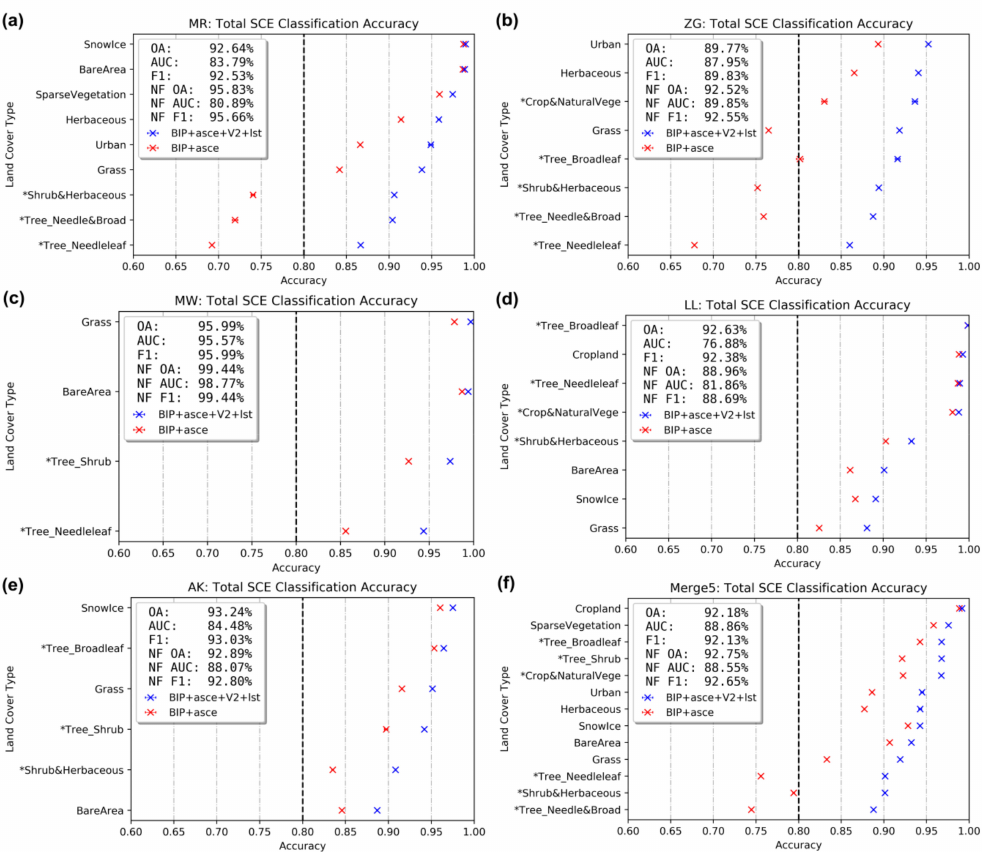
Figure 3. The results of each model set built in each region: ( a ) Monte Rosa (MR); ( b ) Zugspitze (ZG); ( c ) Mount Whitney (MW); ( d ) Landtang Lirung (LL); and ( e ) Aoraki (AK); and merging the five regions ( f ). Di ff erent classification accuracies based on di ff erent input combinations are marked in di ff erent colors, and the accuracy for each land cover class is marked in the same horizontal axis. SAR-based observations, including backscatter, interferometric SAR (InSAR) coherence, and polarimetric (PolSAR) H / A / α parameters are abbreviated as B, I, and P, respectively. Topographical factors, including aspect, slope, curvature, and elevation are abbreviated as a, s, c, and e, respectively. Two vegetation indexes and land surface temperature are abbreviated as V2 and lst,